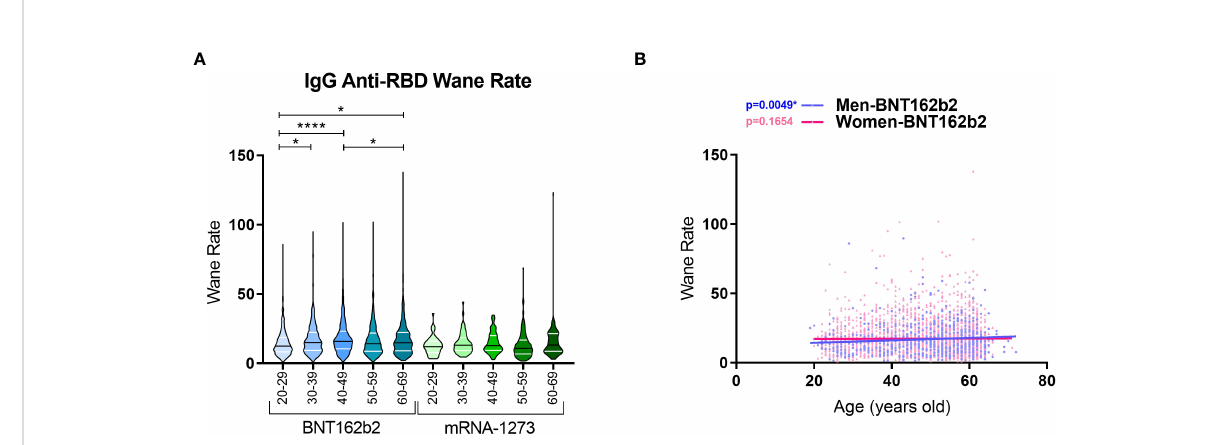
FIGURE 5 Wane ratios of IgG anti-RBD levels in BNT162b2- and mRNA-1273-vaccinated individuals with respect to age ranges. (A) Violin plots represent the waning rate of IgG anti-RBD levels for each individual. The wane rate was calculated by dividing the IgG anti-RBD level on day 30 by the IgG Anti-RBD level on day 240 for each individual. The median (black line) and quartiles (white lines) are represented in the violin plots. A Kruskal Wallis test and a Dunn ’ s multiple comparisons test were performed for each variable. (B) Spearman correlation was calculated for male and female volunteers vaccinated with BNT162b2. * p -value < 0.05, **** p -value <